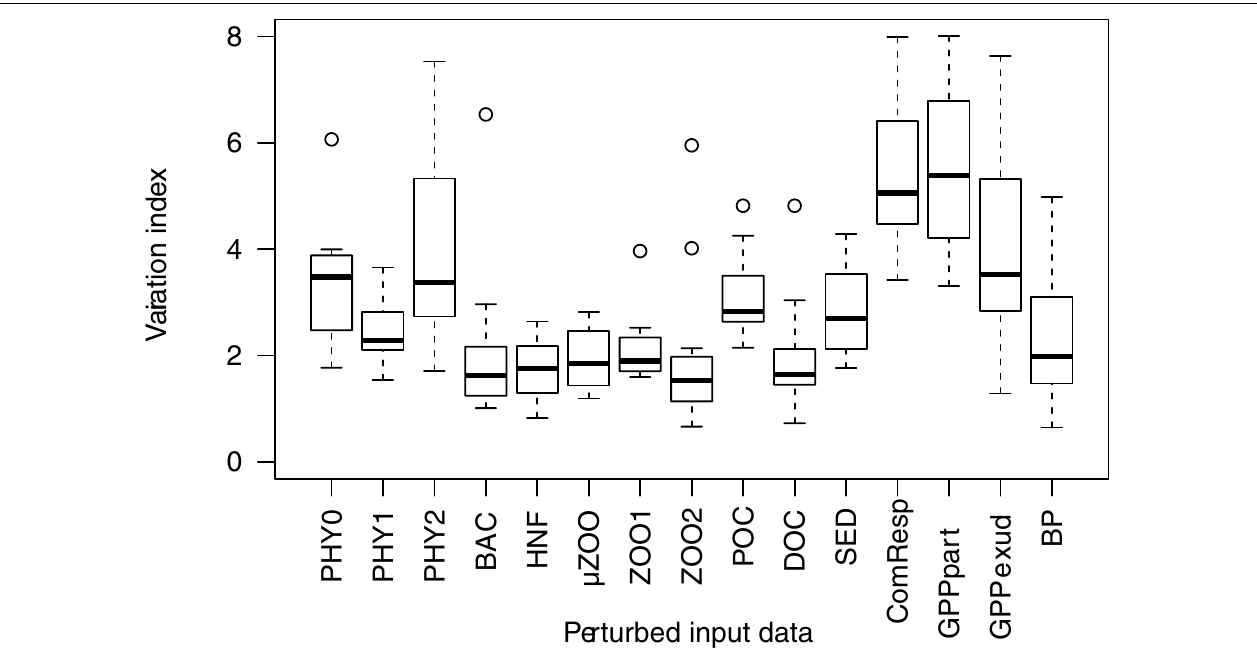
FIGURE 8 | Sensitivity analysis. The boxplots show the spread in the variation index over stations P1–P7. Variation index is calculated as the sum of absolute reconstructed flow changes after perturbing each input variable ( x -axis) at a time and divided by the sum of flows in the unperturbed food web. SED, vertical flux of organic particles; ComResp, measured community respiration; GPPpart, particulate GPP; GPPexud, dissolved GPP; BP, net bacterial production; other x -axis abbreviations as in Table 2